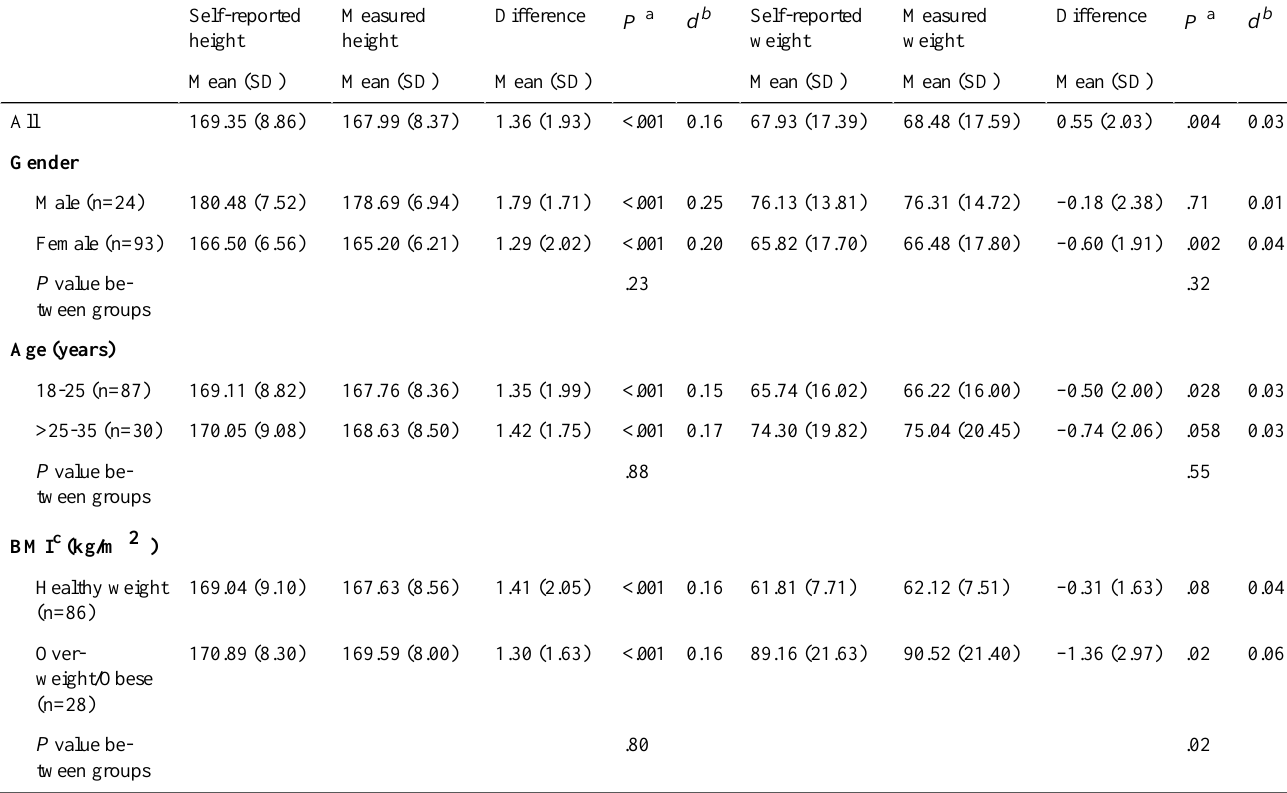
Table 2. Differences between Web-based self-reported and measured height (cm) and weight (kg) in adults (n=117) grouped by BMI, age, and